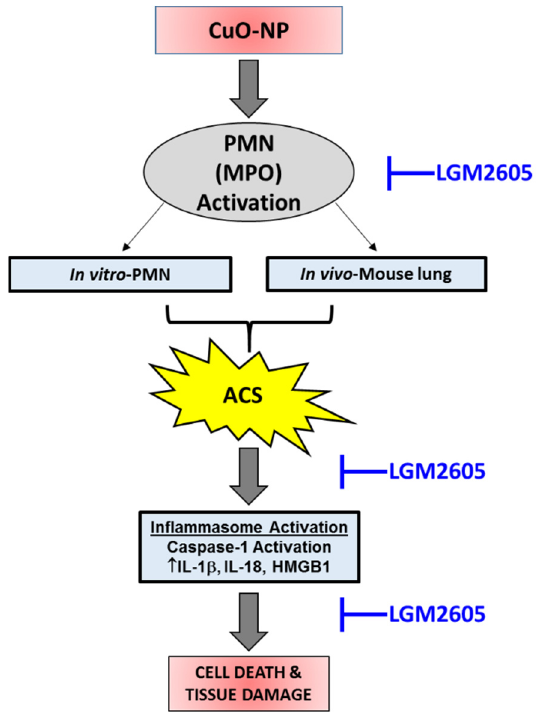
Figure 10. Proposed mechanism of CuO-NP-induced lung toxicity and LGM2605 protection. MPO- dependent, active chlorine species (ACS)-induced inflammasome activation is associated with lung toxicity following CuO-NP exposure. LGM2605 abrogates CuO-NP-induced lung toxicity by reducing ACS generation and inhibiting inflammasome activation.